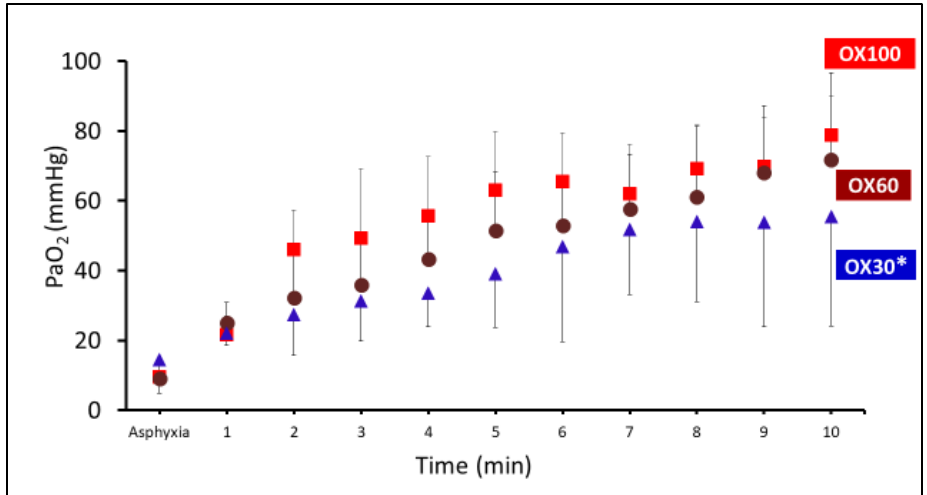
Figure 2. The graph represents the supplemental oxygen used during the resuscitation in OX30 (triangle), OX60 (circle), and OX100 (square) groups. The oxygen was titrated after 2 min. Data are represented as average and standard deviation.